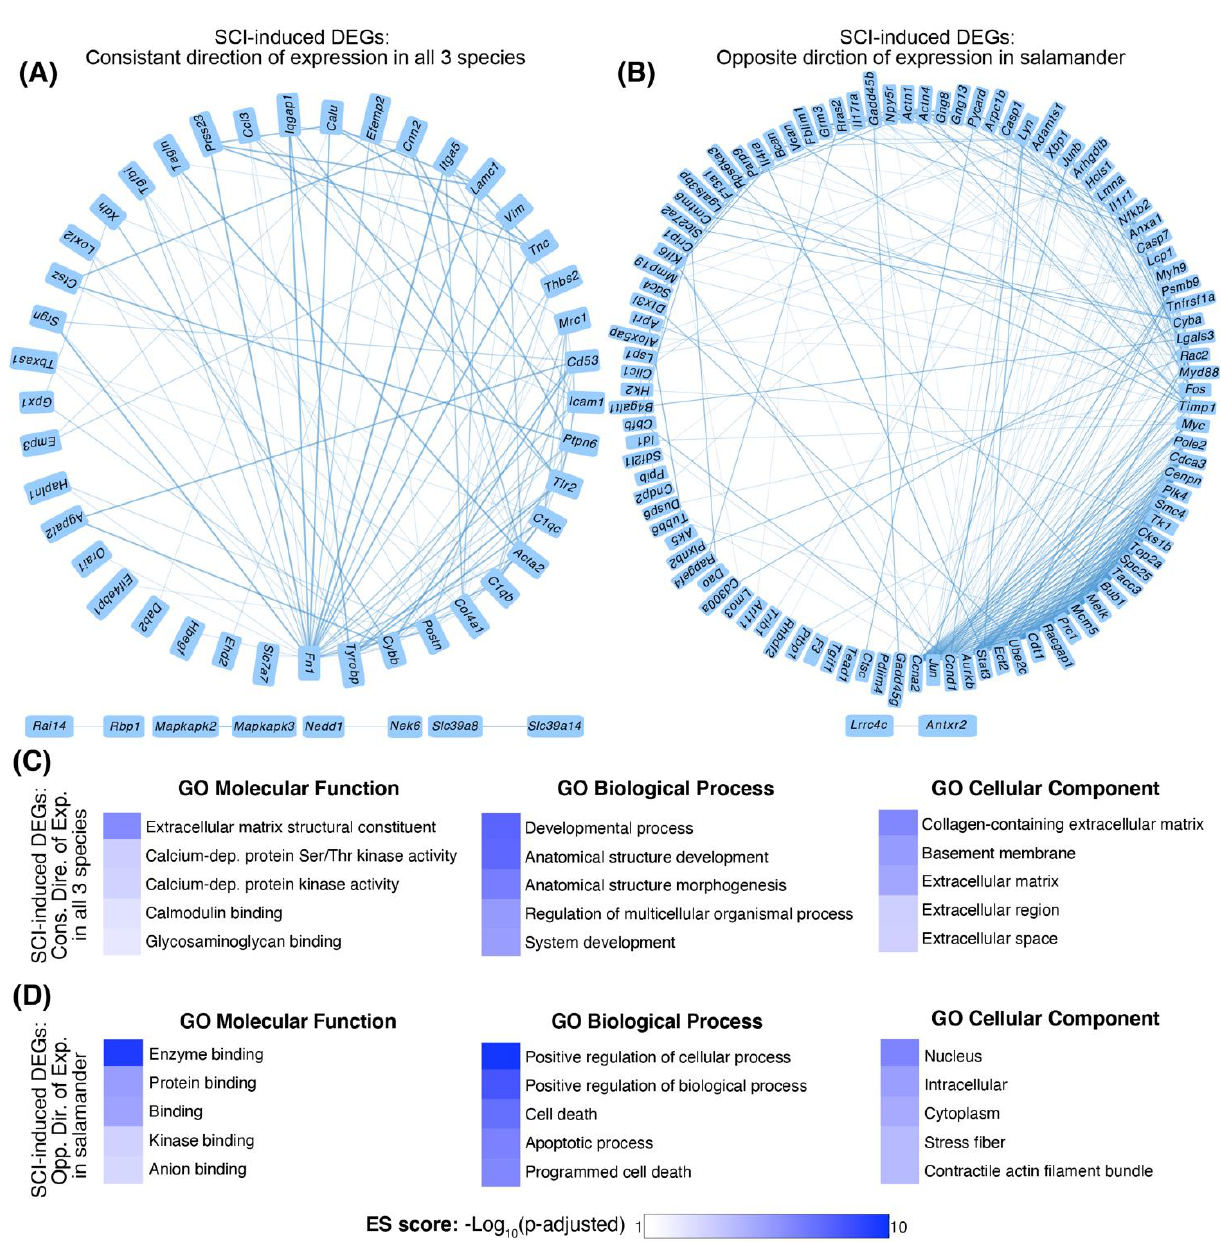
Figure 2. GO enrichment analysis of SCI-induced DEGs at 3/4 dpi. ( A ) The top five GO-Molecular Functions (MF), GO-Biological Processes (BP), and GO-Cellular Components (CC) enrichment scores for the 61 orthologs with a consistent direction of expression in all three species. The most enriched terms include those belonging to the extracellular matrix constituent ( p -adj. = 1.10 × 10 −6 , ES score = 5.96) and development (“anatomical structure development”, p -adj. = 4.78 × 10 −8 , ES score = 7.32). ( B ) GO-MF, GO-BP, and GO-CC enrichment scores for the 119 orthologs with an opposite direction of expression in salamanders. The most enriched terms are related to intracellular components (“nucleus”, p -adj. = 6.44 × 10 −7 , ES score = 6.19) and positive regulation of apoptotic processes, such as “cell death” ( p -adj. = 8.56 × 10 −8 , ES score = 7.06). Enrichment scores are calculated as the -log 10 of the adjusted p -value. ( C , D ) STRING protein-protein network analysis in Cytoscape app. ( C ) Network analysis for SCI-induced DEGs with the consistent direction of expression in all four studies. ( D ) Network analysis for SCI-induced DEGs with opposite directions of expression in salamanders.